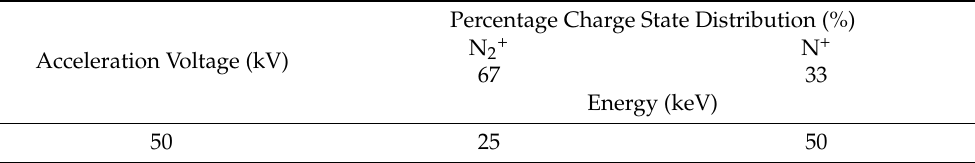
Table 1. Values of acceleration voltage and energy of the nitrogen-implanted